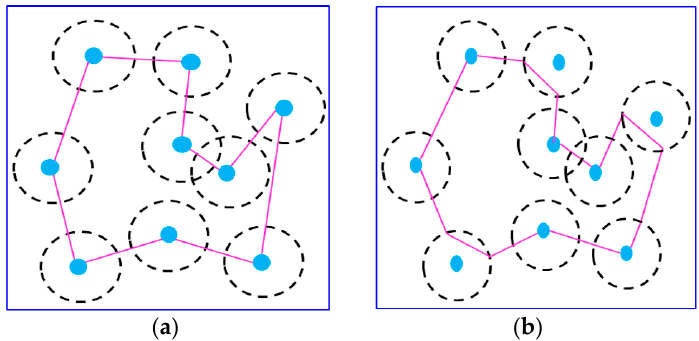
Figure 15. Example of recharging path reduction by applying the second clustering mechanism. ( a )